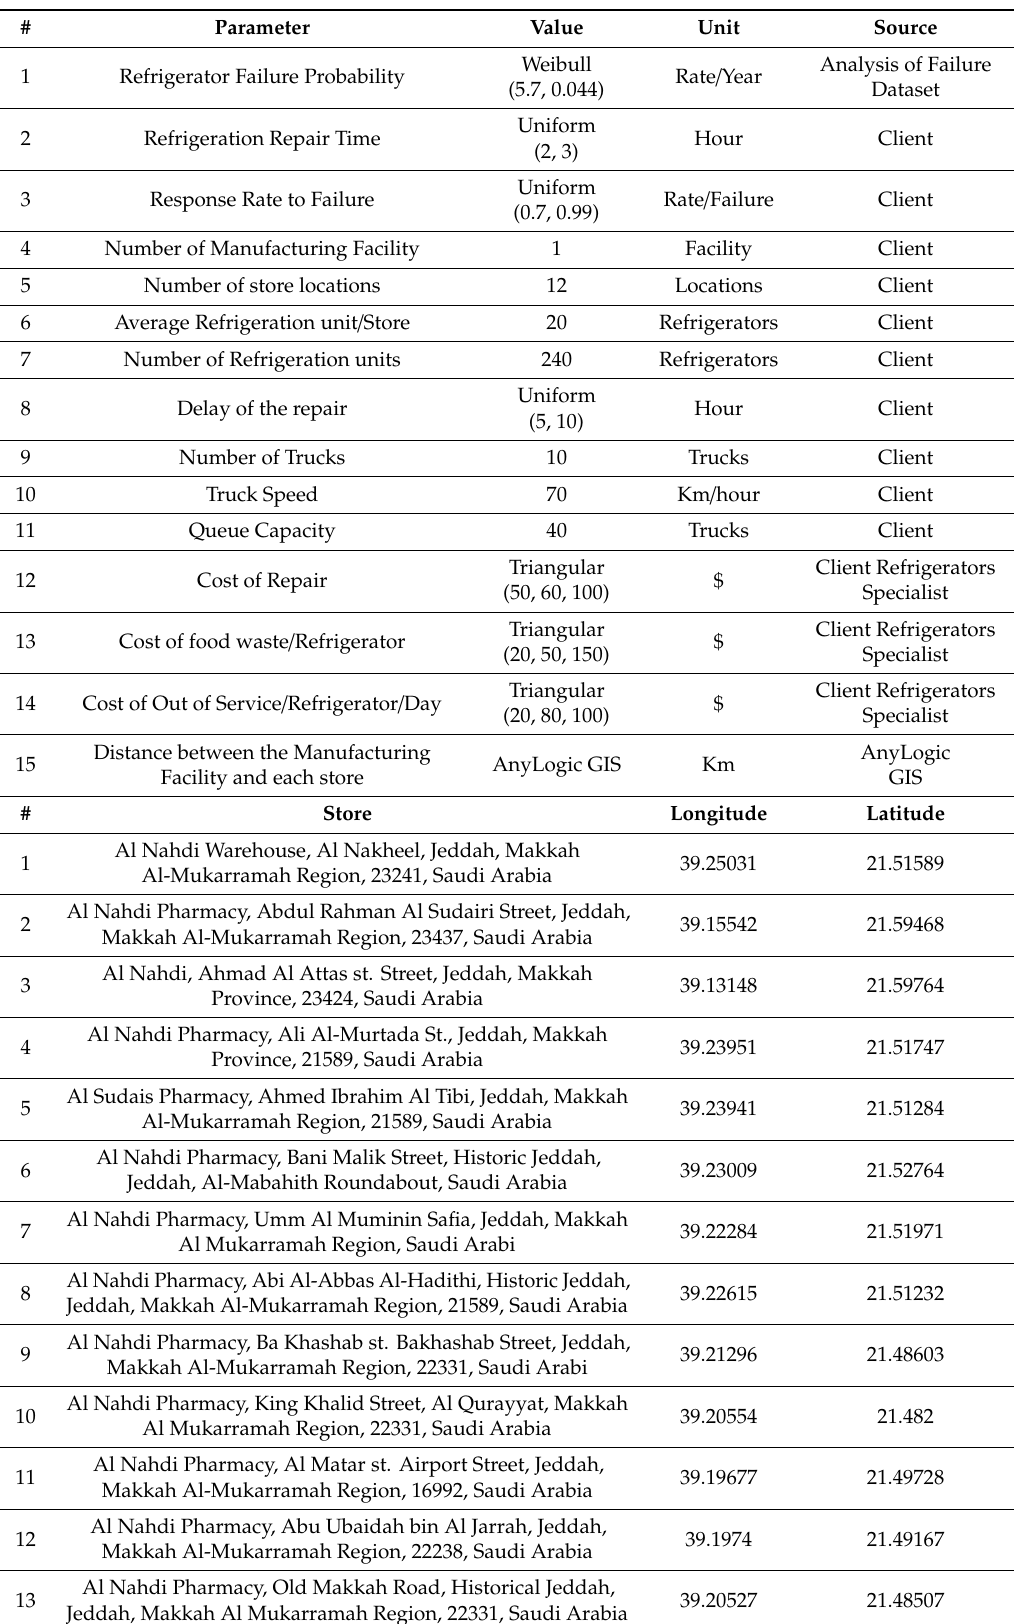
Table 2. Simulation input